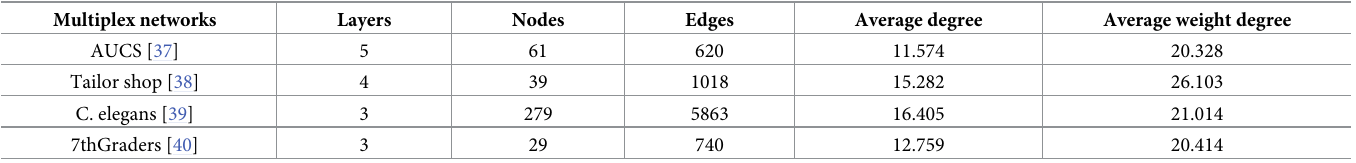
Table 2. Four actual multiplex network node connection data.